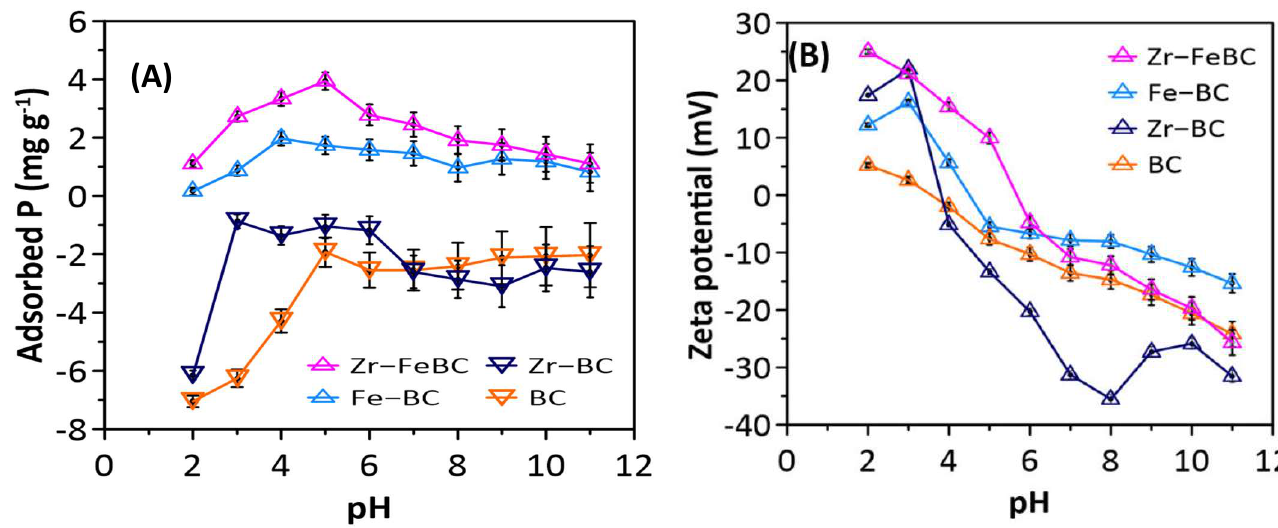
Figure 1. Effect of pH on P adsorption by biochars ( A ) (initial concentration of P was 10 mg L -1 , biochar concentration was 2 g L –1 , temperature was 22 ± 0.5 °C), and isoelectric point (pH PZC ) of biochars ( B ).